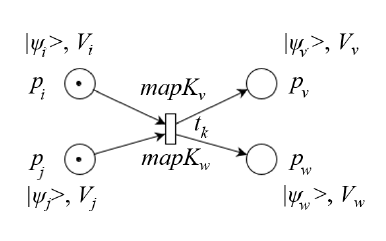
Figure 3. Quantum Petri net